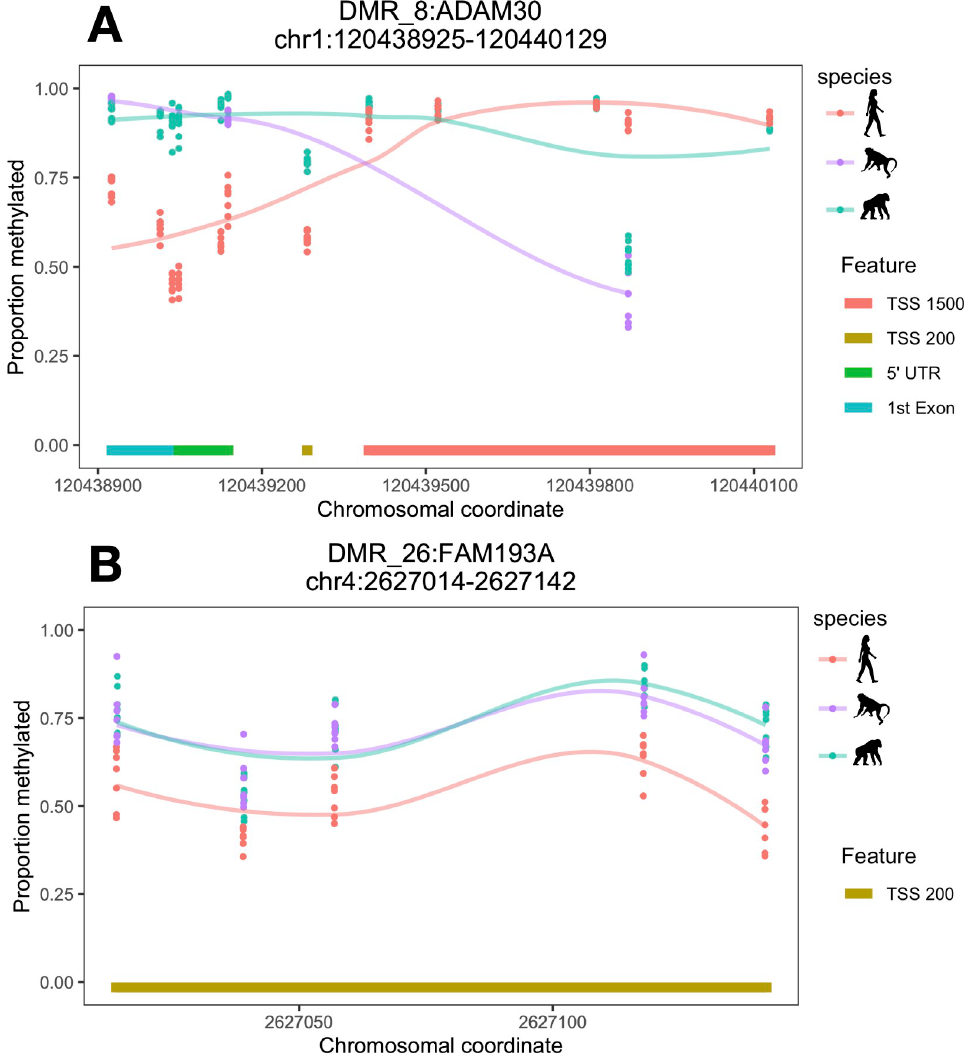
Fig 2. DLPFC-specific human regDMRs associated with ADAM30 and FAM193A . A = ADAM30 , B = FAM193A . Lines are loess smoothed methylation values for each species across the DMR and each point represents raw methylation values for each individual at each CpG site within the DMR ranges. TSS200 = within 200 bp of a transcription start site and TSS1500 within 1500 bp of a transcription start site. Chromosomal coordinates are in base pairs and refer to human genome build